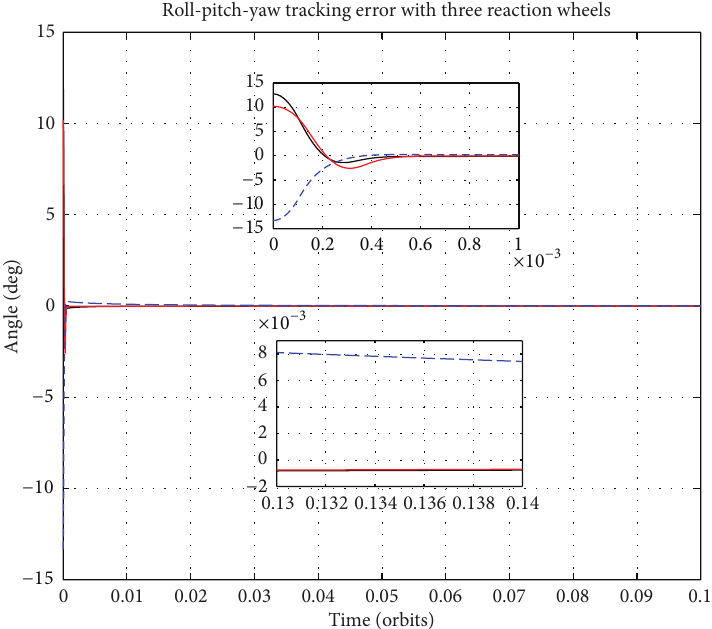
Figure 11: Scenario 5 nadir pointing control results using three wheels: Euler angle tracking errors.